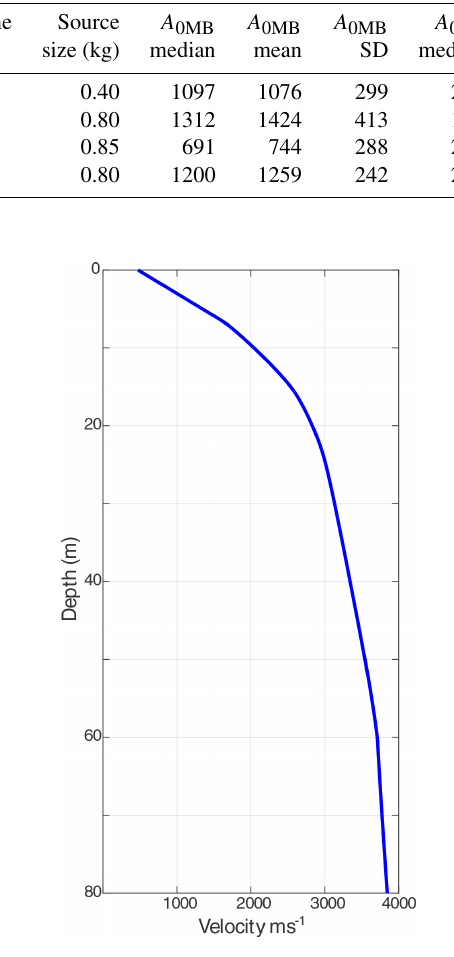
Figure 2. One-dimensional compressional wave velocity profile es- timated using the τ – p